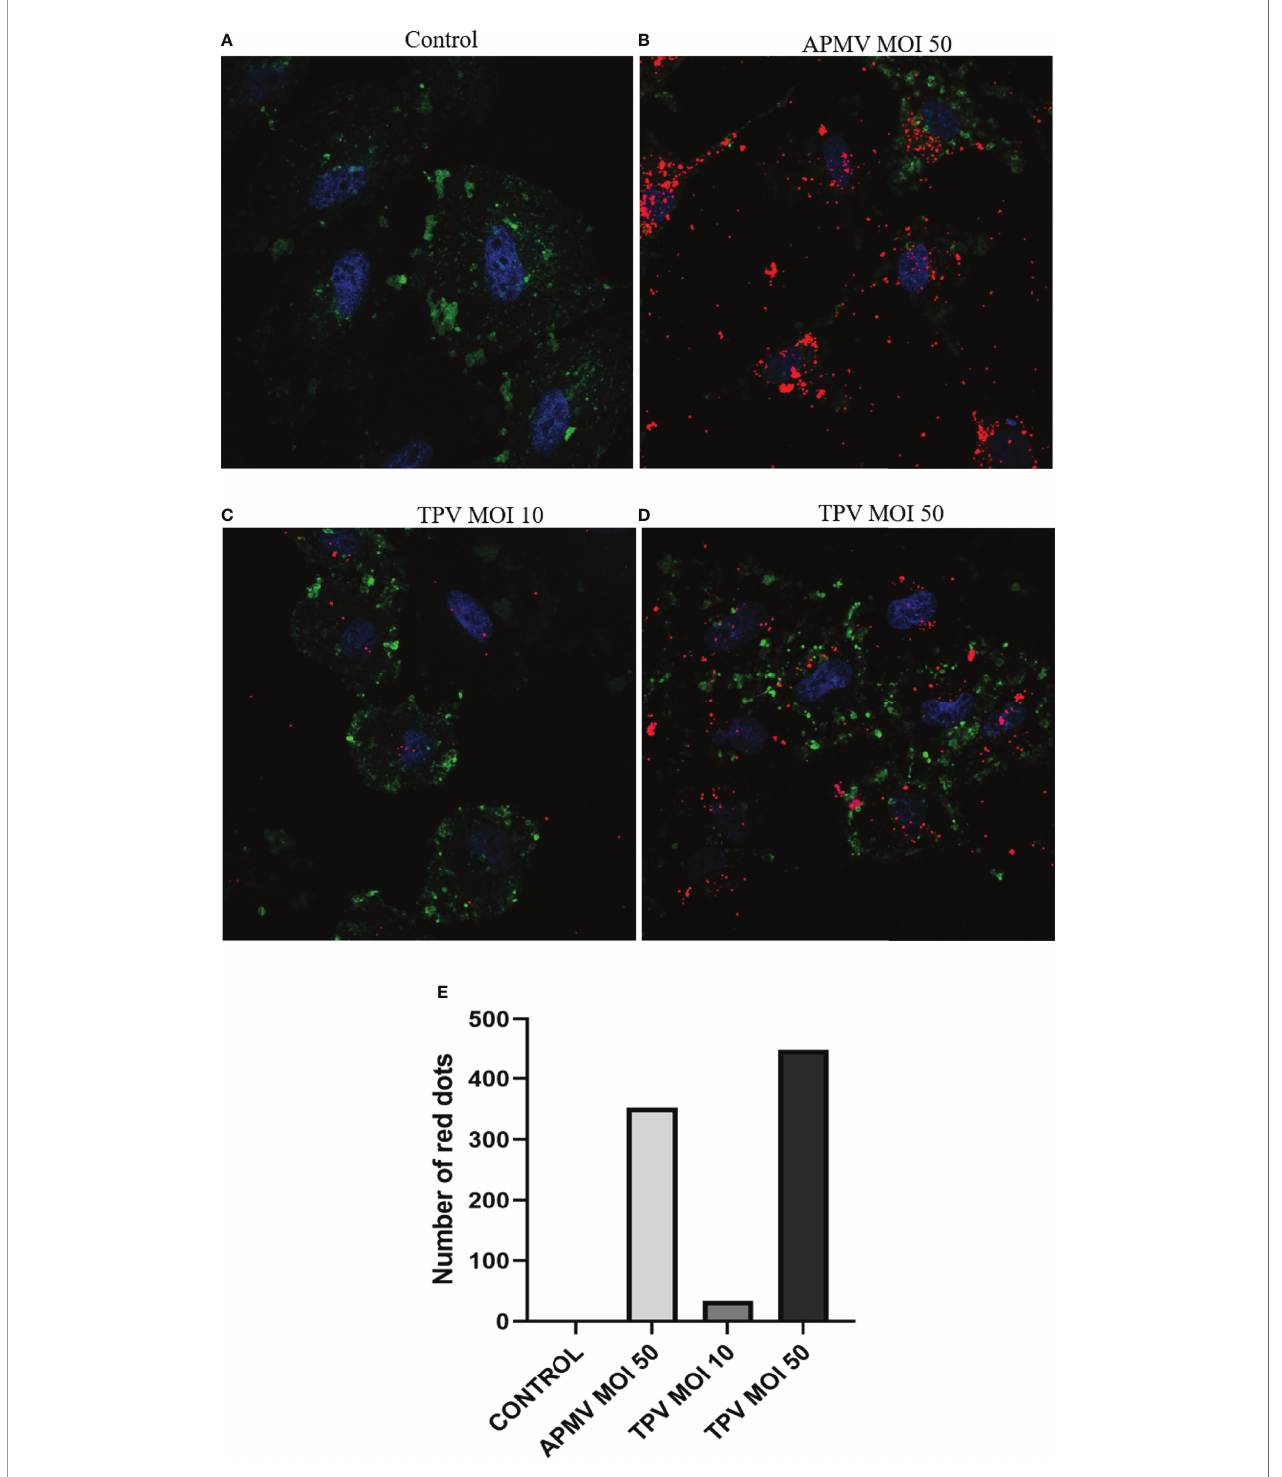
FIGURE 2 | Interaction of APMV and TPV with A549 cells after 36 hours. Fluorescent microscopies showing the A549 cells invasion by rhodamine-phalloidin-labeled APMV and TPV (red). A549 cells were incubated with APMV (MOI of 50) and TPV (MOI 10 or 50) for 6 hours, and labeled with FITC-CTB (green cell membrane) and DAPI (blue-core). (A) Cell in DMEM, (B) Cells incubated with APMV (MOI 50), (C) Cells incubated with TPV (MOI 10) and (D) Cells incubated with TPV (MOI 50). Scale bar: 10 µm. (E) Graph representing the number of APMV and TPV particles (red dots) internalized by